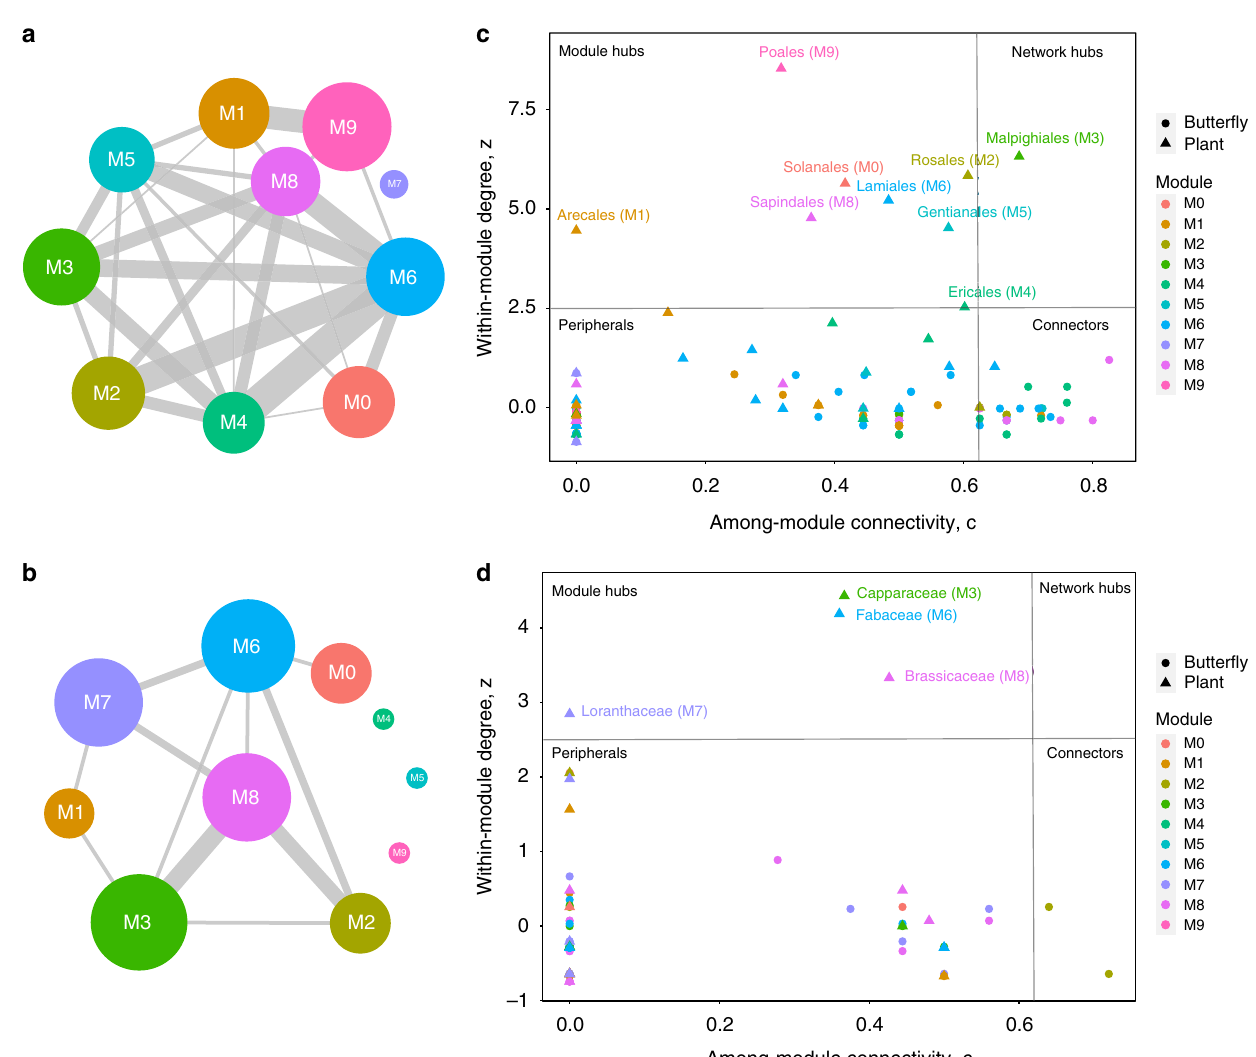
Fig. 3 Overview of the modular structure and detailed contributions of taxa in the networks. a , b Graph of module interactions for the nymphalid and pierid networks, respectively. Circle size re fl ects the number of butter fl ies and plants within each module, and the width of the links (grey lines) between them re fl ects the number of interactions between modules. c , d Relative contribution of each taxon to the modular structure, de fi ned by measures of connectivity with taxa within the same module ( y axis) and with taxa assigned to other modules (x-axis) of the nymphalid and pierid networks. Names of modules and network hubs are shown. Colours of modules are consistent with Figs. 2 and